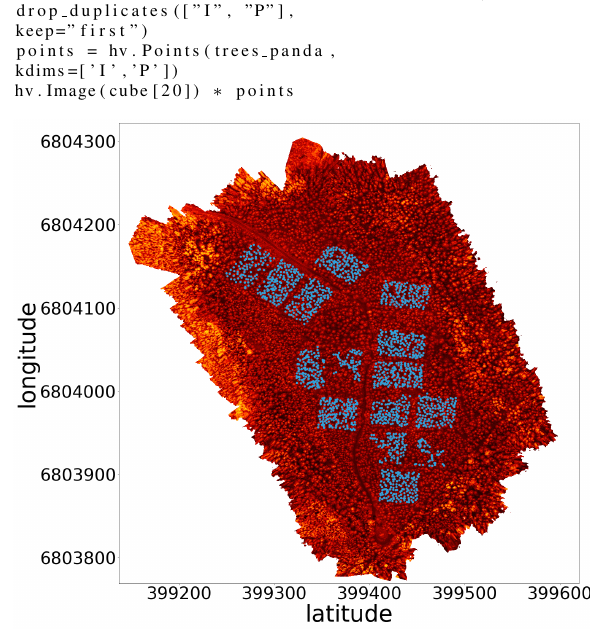
Figure 18. Visualisation of the trees over the image. In this block we read tree data as pandas DataFrame and visualise the trees on the top of one band of the cube.